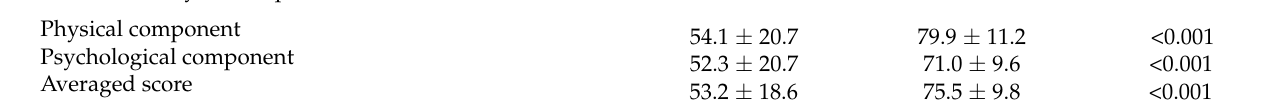
Before Therapy, After % ( n = 32)